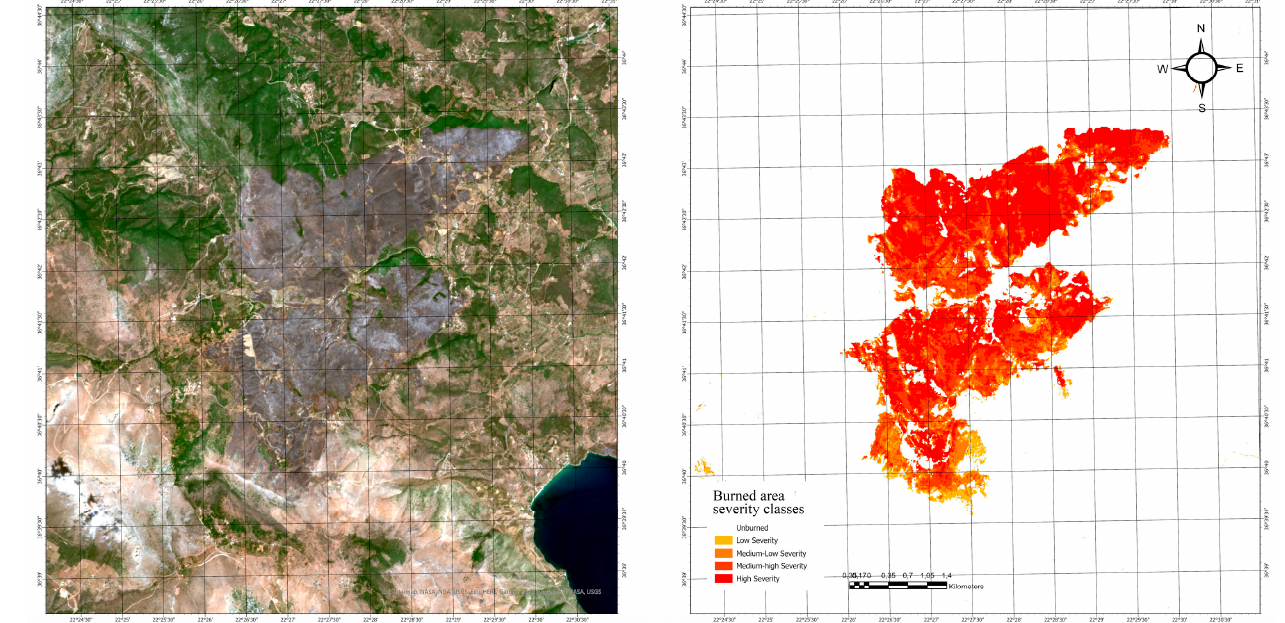
Figure 6. RGB true color representation (using Sentinel-2 bands) of the wider area of Eastern Mani, Greece ( left ), and the burned area classified into 4 severity classes ( right ).